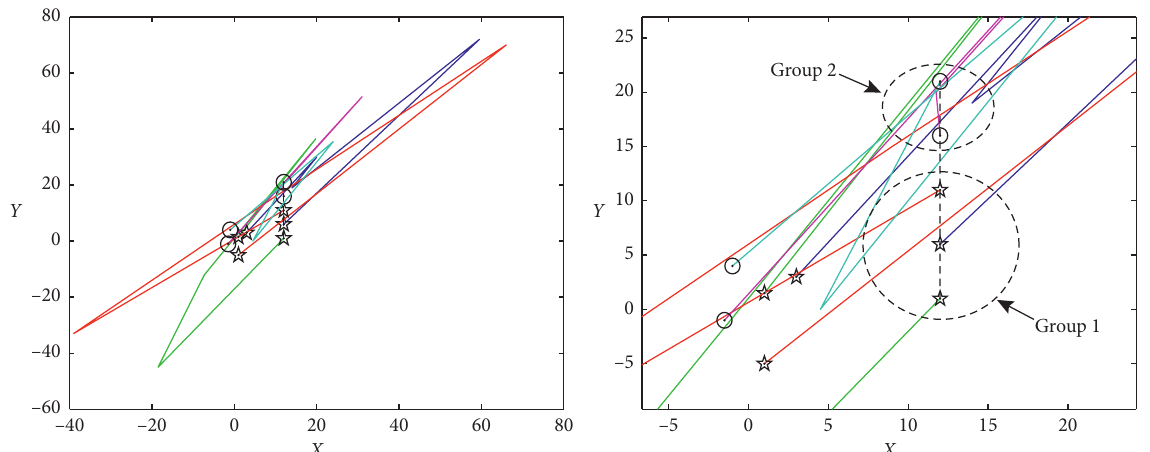
Figure 4: A straight line array and its local magnification portion.